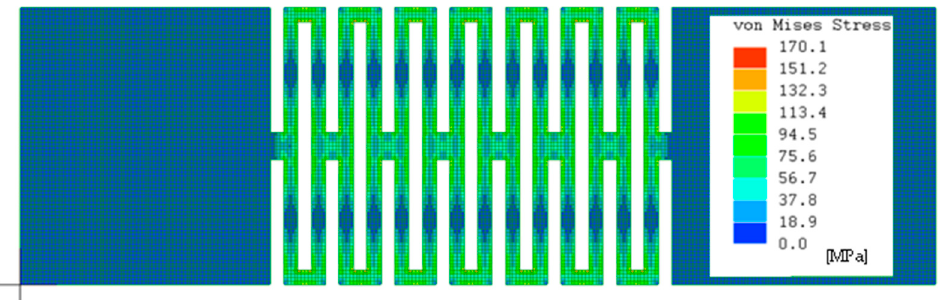
Figure 8. Von Mises stress distribution by FEM analysis with 2.5 mm grid elements (F-7).